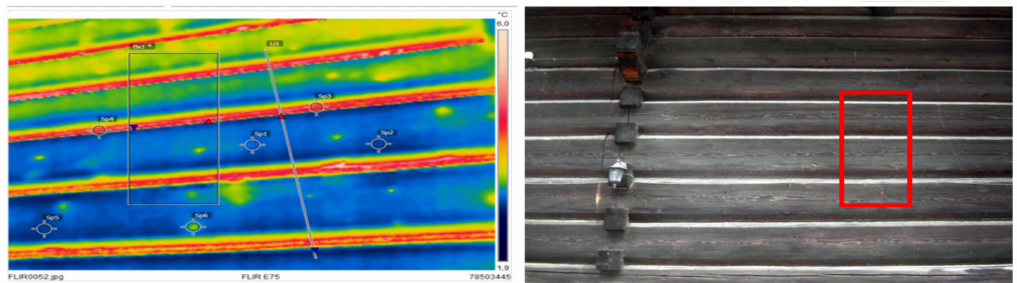
Figure 10. Detailed thermovision analysis of the Stara Polana building using a FLIR camera. Fragment of an external wooden log wall.